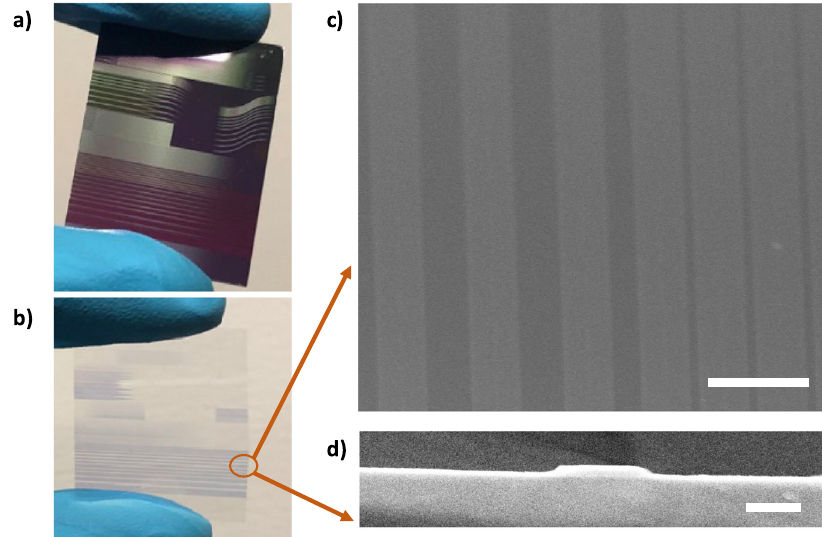
Fig. 2 Fabricated waveguide chips on both transparent and opaque substrates. Photographs of the fabricated waveguide chips after back-end processing on either a an opaque substrate or b a transparent substrate. SEM images showing the clean fabrication of a waveguide chip on the transparent substrate from ( c ) a top view, with a scale bar of 10 μ m and where the waveguides appear as dark lines and d a cross-section of the waveguide input facet with a scale bar of 1 μ m. The width and height of the fabricated waveguide shown in ( d ) are 1500 and 250 nm, respectively, and the sidewall angle is ~85°.